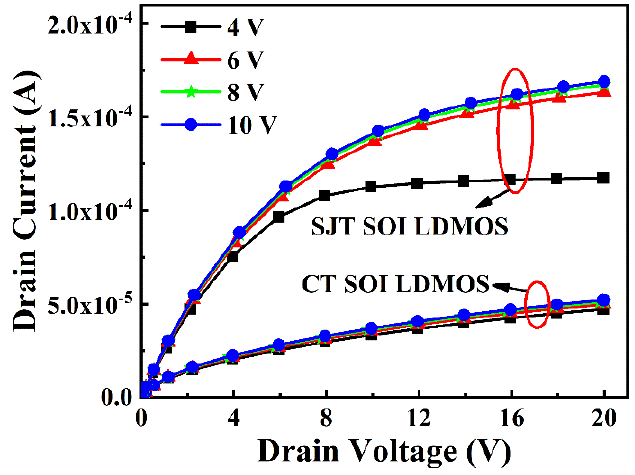
Figure 5. I–V characteristic curves of the CT SOI LDMOS and SJT SOI LDMOS.